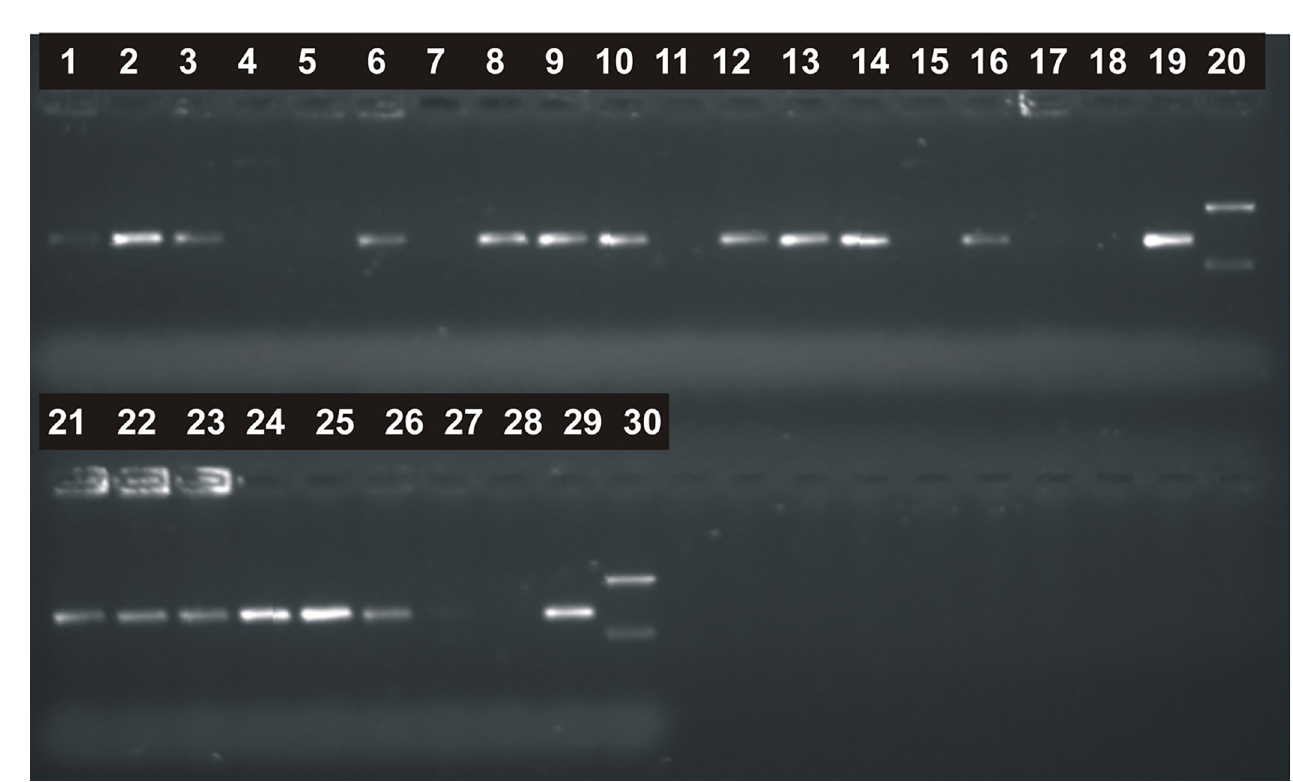
Fig 6. The prevalence of the 5 bacterial species with respect to the age of the